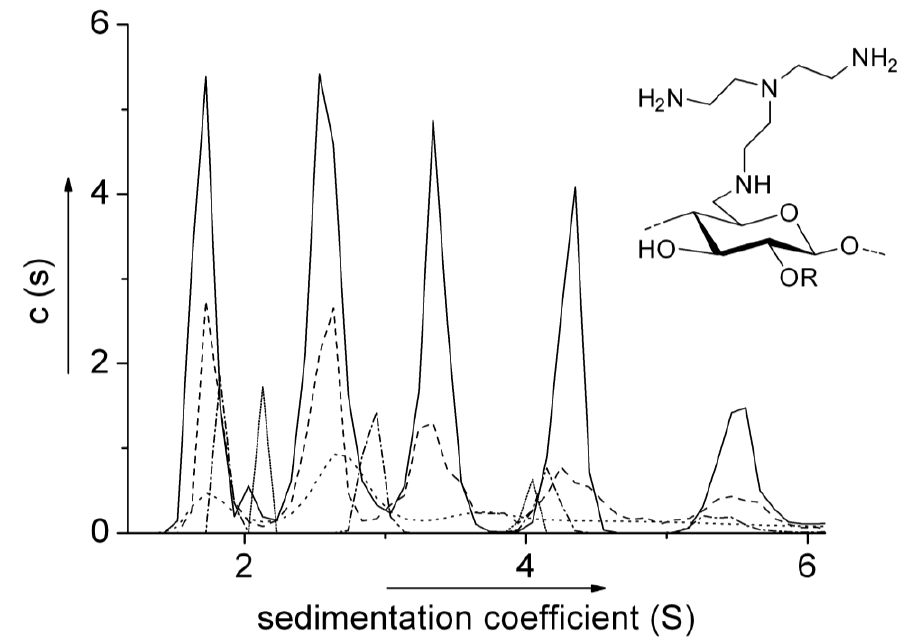
Figure 2. Sedimentation coefficient distributions of a 6-deoxy-6-amino cellulose (BAEA cellulose) at various concentrations: solid (──) 2.0 mg/mL; dash (– –) 1.0 mg/mL; dot (∙∙∙∙∙∙) 0.5 mg/mL; dash dot (– ∙ – ∙) 0.25 mg/mL; short dot (∙∙∙∙∙∙) 0.125 mg/mL. Reproduced from [13] with permission from